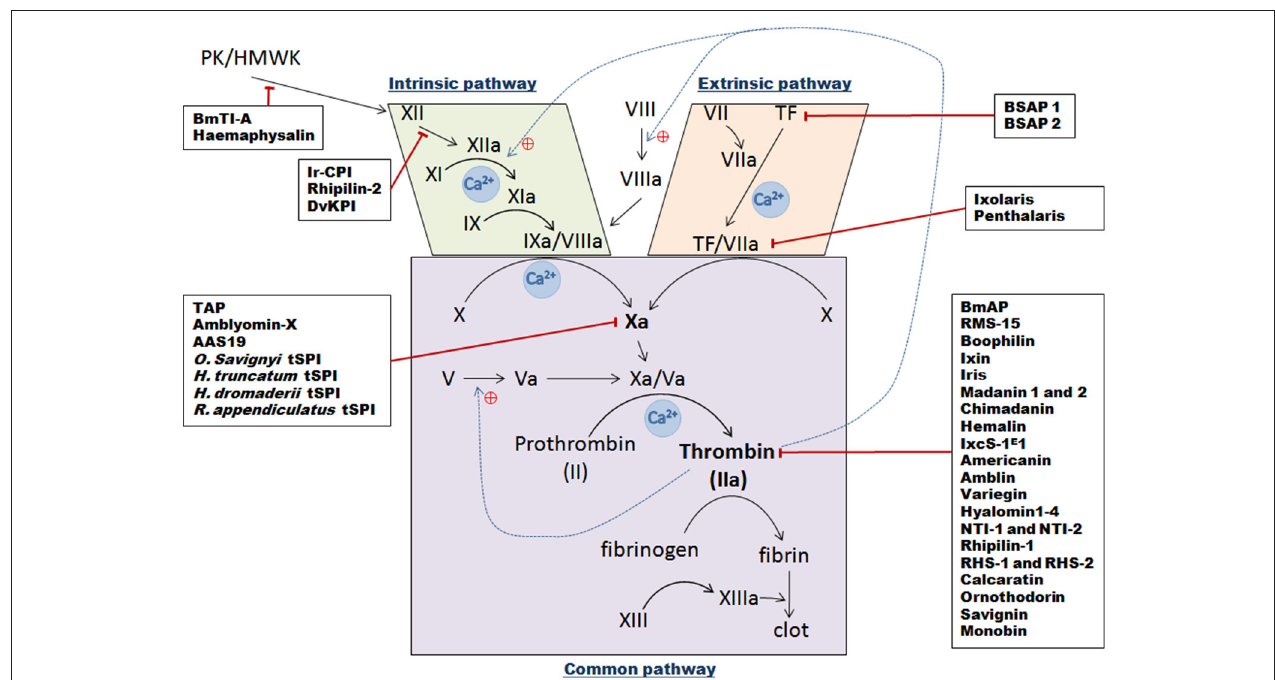
FIGURE 3 | Schematic overview of the three vertebrate blood coagulation cascade pathways, with indicated tick serine protease inhibitors and their targets. The intrinsic pathway is activated following a trauma and when blood comes into contact with subepithelial cells [contact phase with XII, Prekallikrein (PK), and High Molecular Weight Kininogen molecules (HMWK)], which then results in successive activation of factors XII, XI, and IX. The IXa/VIIIa complex then activates transformation of factor X into factor Xa. The extrinsic pathway is initiated following contact between Tissue Factor (TF) from vessels and circulating factor VII. After injury, they form a complex and catalyze the activation of factor X into factor Xa. Once activated by either pathway, factor Xa complexes with its cofactor Va to form the pro-thrombinase complex, which can then convert prothrombin into thrombin. Thrombin then transforms fibrinogen into fibrin to create a plug. Black arrows represent direct activation, dotted blue lines show positive thrombin feedback, red lines correspond to tSPI inhibition